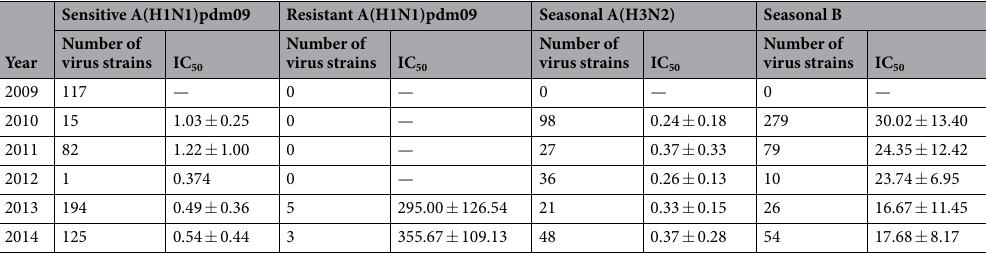
Table 2. IC 50 values for oseltamivir for the randomly tested isolates ( x ± SD, nM). “—” = “Not determined”.